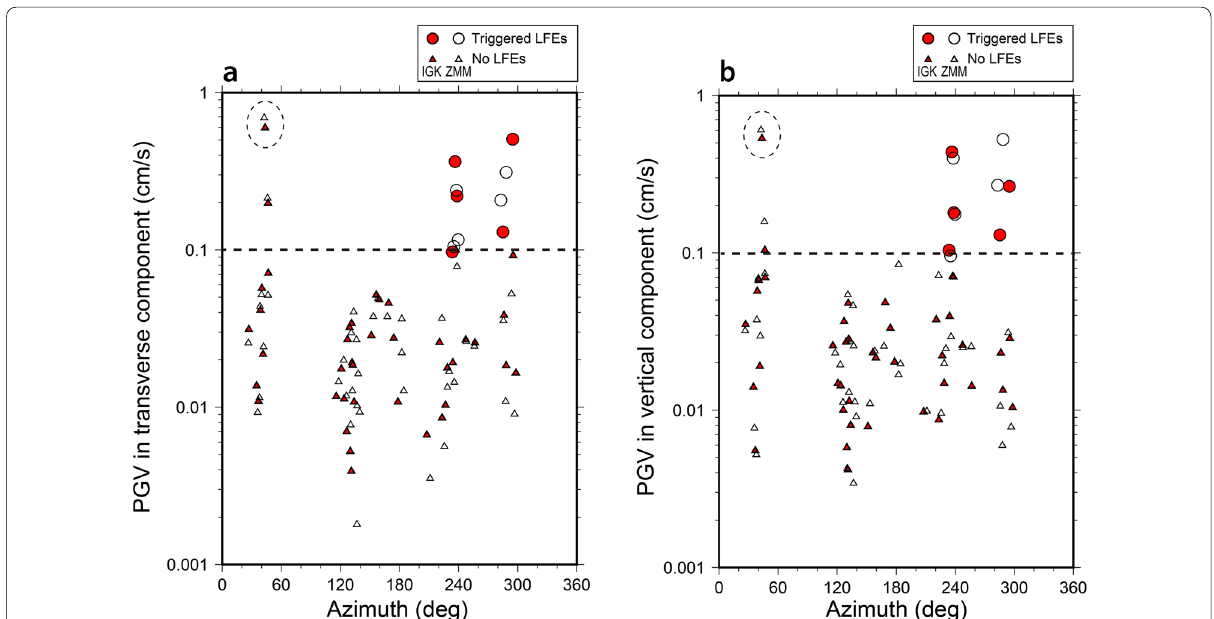
Fig. 5 PGV as a function of azimuth at IGK and ZMM. a PGV in transverse component as a function of incident azimuth to the stations. Circles show the data points for triggered LFEs. Triangles show the events where the triggered LFEs were not observed. Solid and open marks show the data points at IGK and ZMM, respectively. Ellipses show the data for the 2011 Tohoku-Oki earthquake. b The same as a but for the vertical